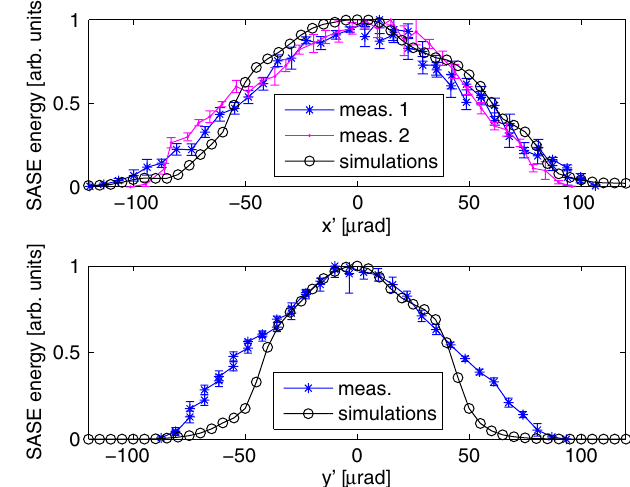
FIG. 5. (Color) Measurements and simulations of SASE sensi- tivity to the incoming trajectory.